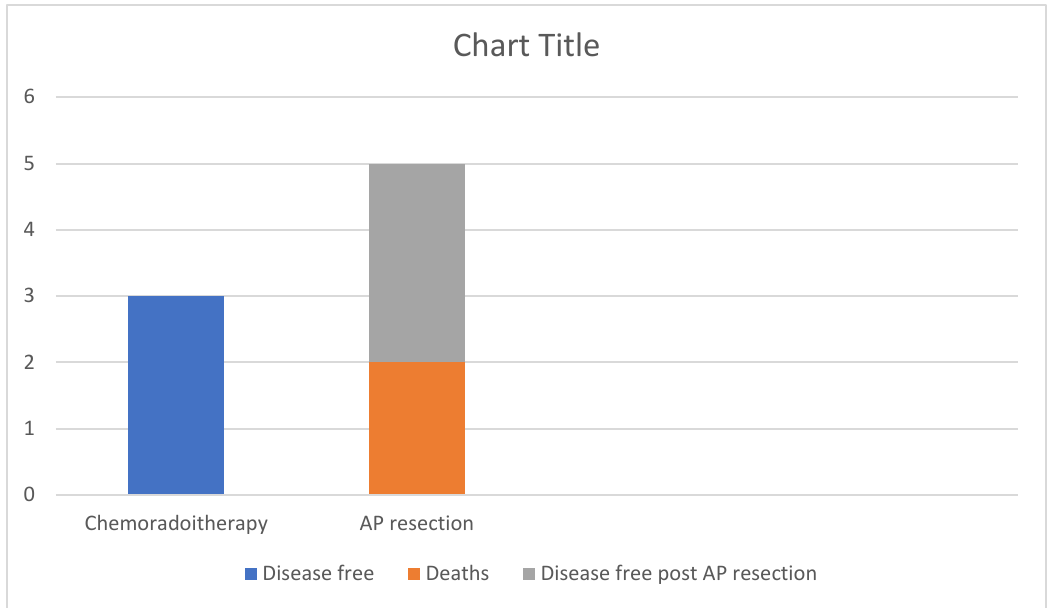
Figure 7. Outcomes of the patients with invasive SCC. 50% remain disease free after chemoradio- therapy alone, while of the 50% that required AP resection after relapse 60% remain disease free at 5 years post-operatively and 40%